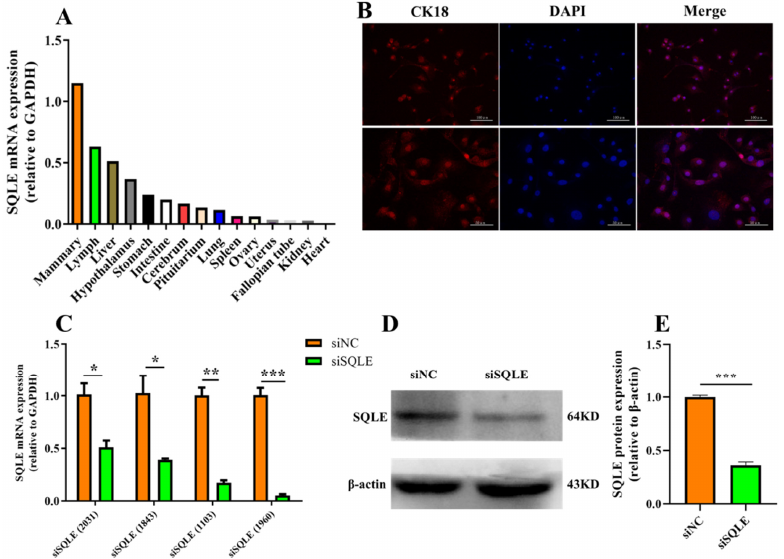
Figure 3. SQLE gene expression profile and interference efficiency. ( A ) mRNA expression profile of SQLE in different tissues of buffalo by quantitative real-time PCR method; ( B ) immunofluorescence identification of BuMECs with cytokeratin 18; ( C ) BuMECs were transfected with siSQLE, and fluorescence quantitative qPCR was used to detect the SQLE mRNA levels; ( D , E ) Western Blot detected the protein expression of SQLE . n = 3 biological replicates. * p < 0.05, ** p < 0.01, *** p < 0.001, compared with control group. Error bars represent SEM. 2.5. SQLE Regulates the BuMECs Proliferation, Cell Cycle, and Apoptosis Flow cytometry analysis for the cell cycle indicated that the cell cycle was arrested in siSQLE-treated cells compared to the control, as there was a significant decrease in the G2 (3.53%, p < 0.05) and increase in the G1 (6.42%, p < 0.05) phase (Figure 4A–C). Further- more, the apoptosis rate was determined by transfecting BuMECs for 48 h with siSQLE or siNC. The results showed that siSQLE-treated BuMECs had a significantly higher early (5.47 ± 0.72), late (6.66 ± 0.23), and total apoptosis rate (12.13 ± 0.49) compared to the siNC (early apoptosis rate: 0.29 ± 0.09; late apoptosis rate: 1.19 ± 0.25; total apoptosis rate: 1.48 ± 0.26), respectively ( p < 0.01, Figure 4D–F). Meanwhile, to confirm the SQLE role in cell proliferation, we performed CCK-8 assays to examine the effect of SQLE on the viability of BuMECs. The results demonstrated that cell viability was significantly reduced by SQLE knockdown ( p < 0.001, Figure 4G). In addition, the cell counts were measured with an automatic cell counter, and the results revealed a significant decrease in the number of cells in SQLE knockdown cells ( p < 0.001, Figure 4H). Consistently, SQLE gene knock- down inhibits the cell cycle, proliferation, and apoptosis-related gene ( PCNA , MYC , and P21 ) expression ( p < 0.05, Figure 4I).